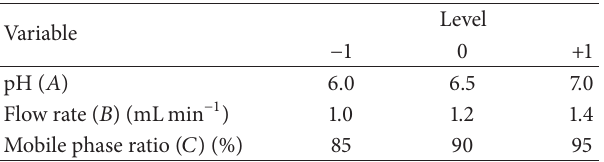
Table 1: The experimental variables and levels of